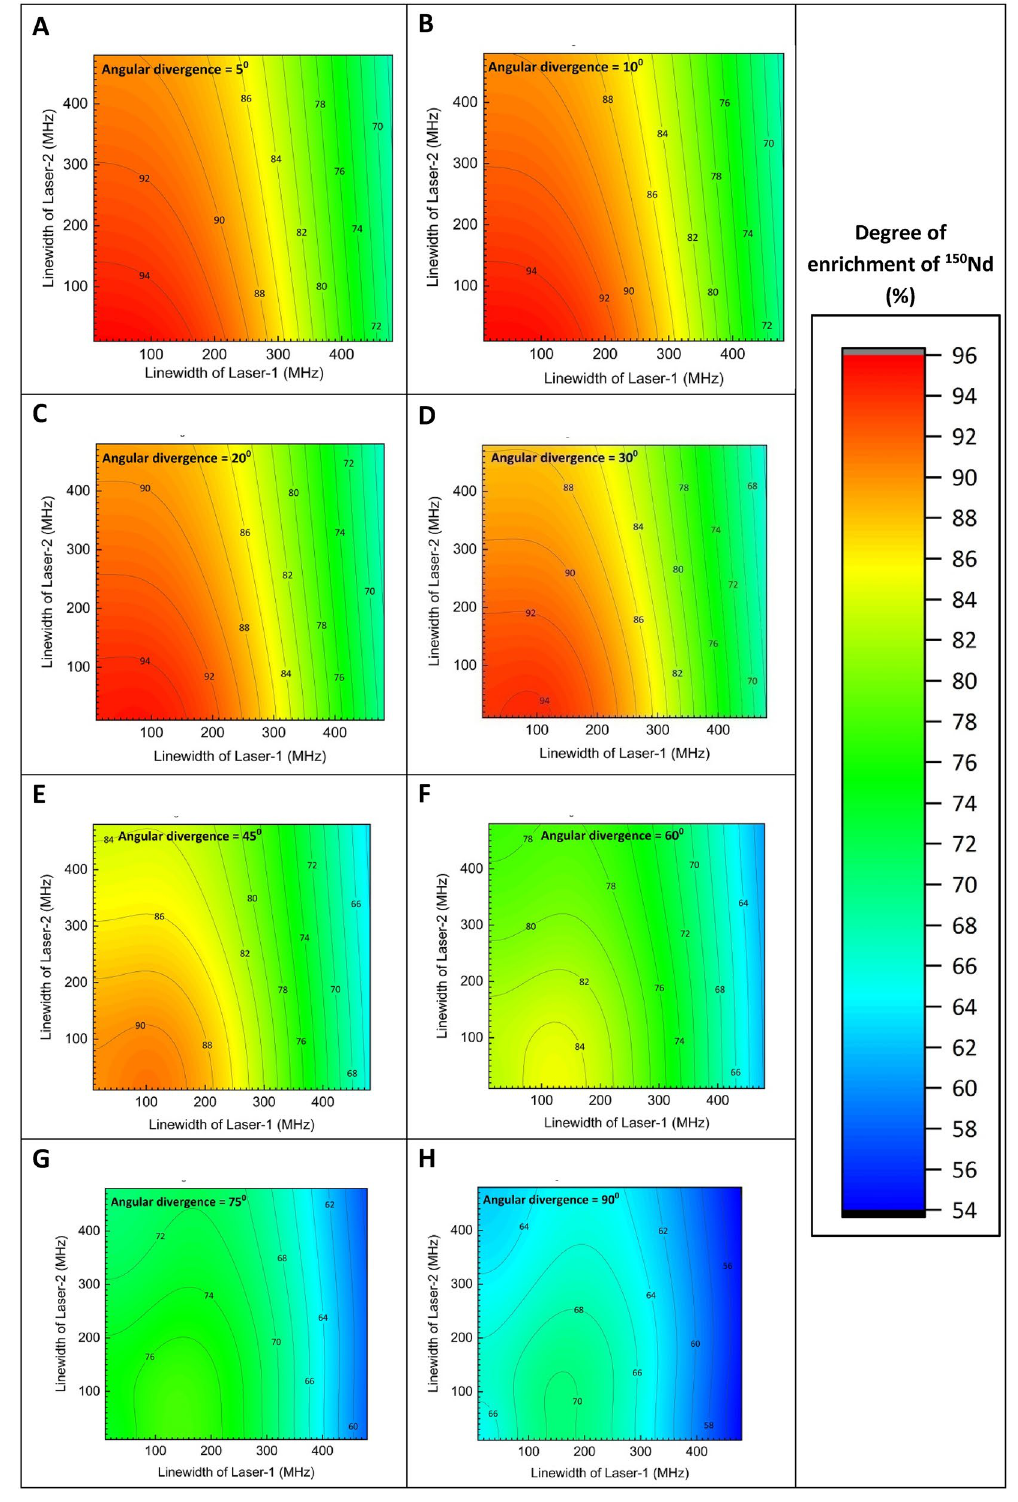
Figure 4. A plot of the dependence of the degree of enrichment on the bandwidth of excitation lasers calculated for various angular divergence values. Peak power densities of the first, second and third lasers have been set to 20, 20 and 78,000 W/cm 2